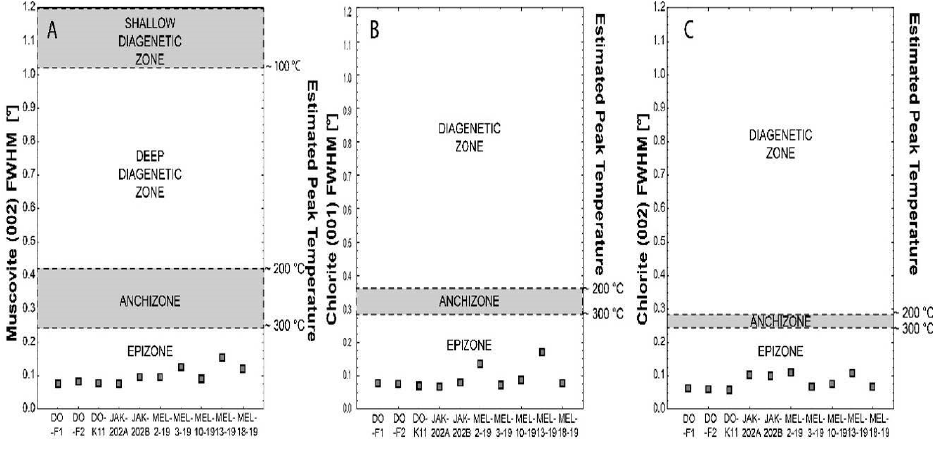
Figure 31. Determination of diagenetic zone, anchizone and epizone in Meliata Unit flysch metasediments from the comparison of Ms (002), Chl (001) ( A ) and Chl (002) ( B ) diffraction maxima FWHM values from [121]. Values from Table 13.